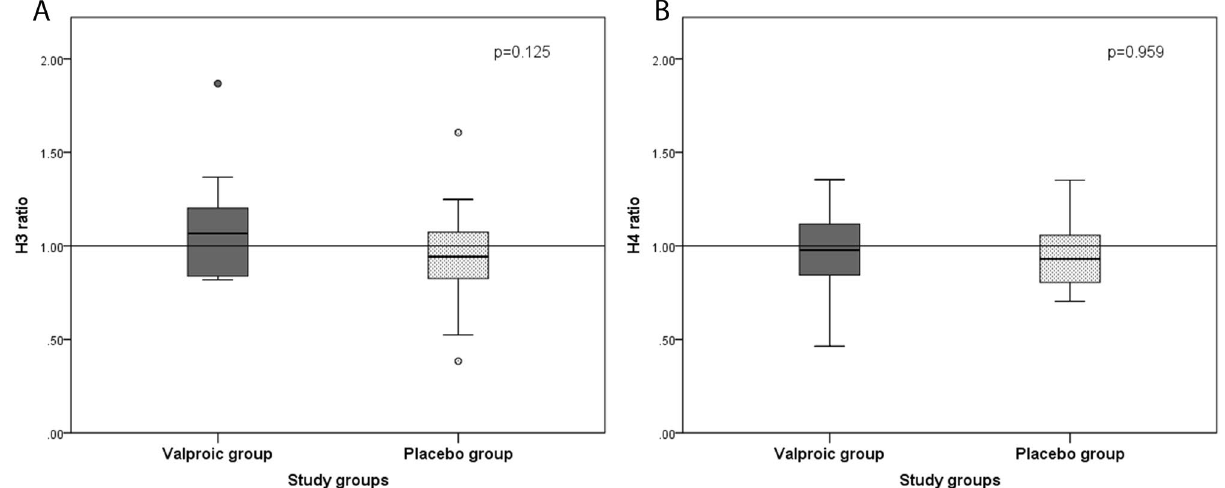
Figure 1. Comparison of the medians of the T1/T0 histone acetylation ratios H3 ( A ) and H4 ( B ) in oral rinse samples between the valproic and placebo groups. The boxplots presented above show the median, maximum and minimum values, interquartile range and outliers (represented by circles) in the two study groups. The dashed line passing through 1 indicates that the group participants located above the line were acetylated.